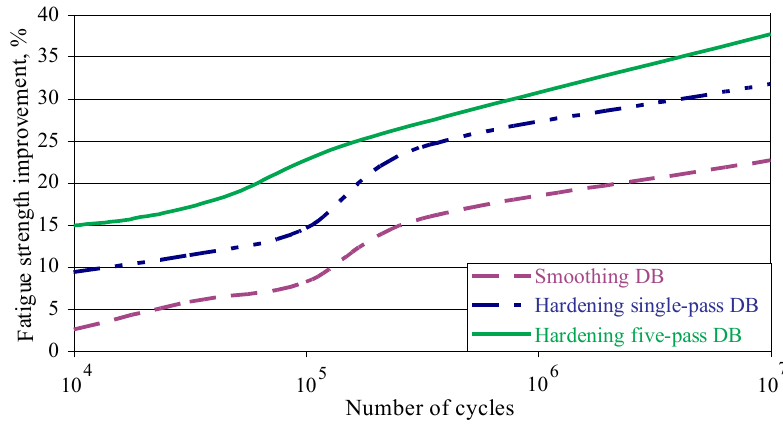
Figure 17. Fatigue strength improvement.